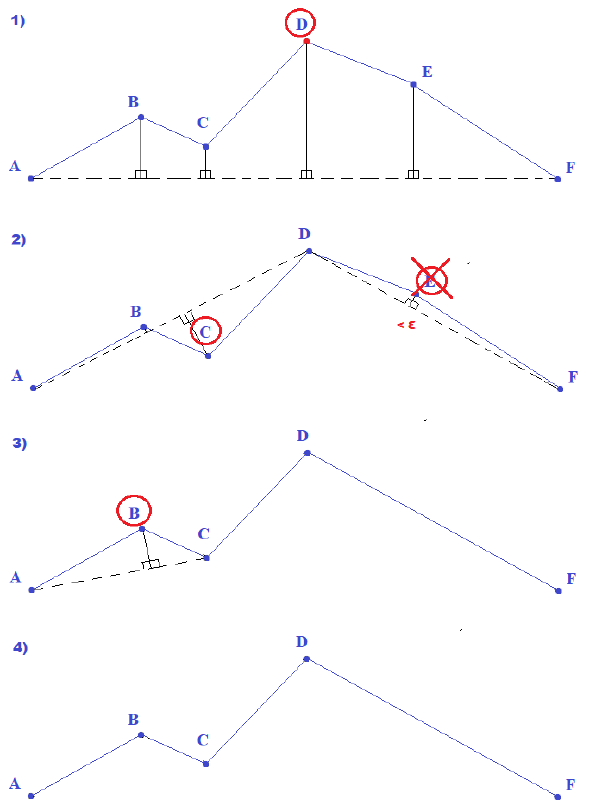
Figure 6. Interpolation strategies following Douglas–Peucker.